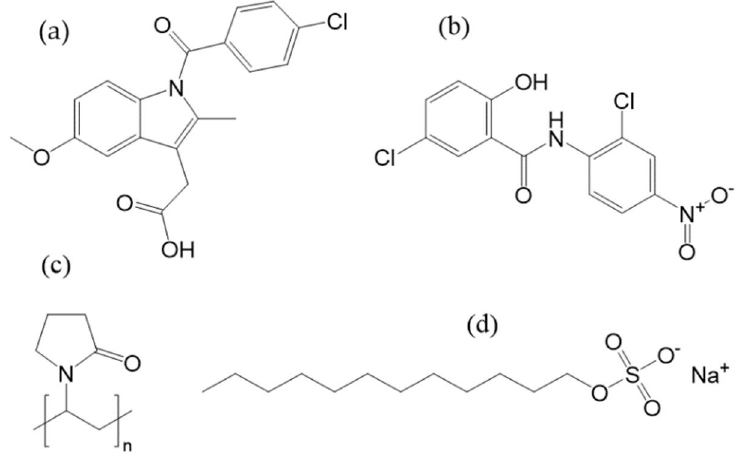
Figure 2. Chemical structure of ( a ) indomethacin, ( b ) niclosamide, ( c ) PVP and ( d ) SDS.